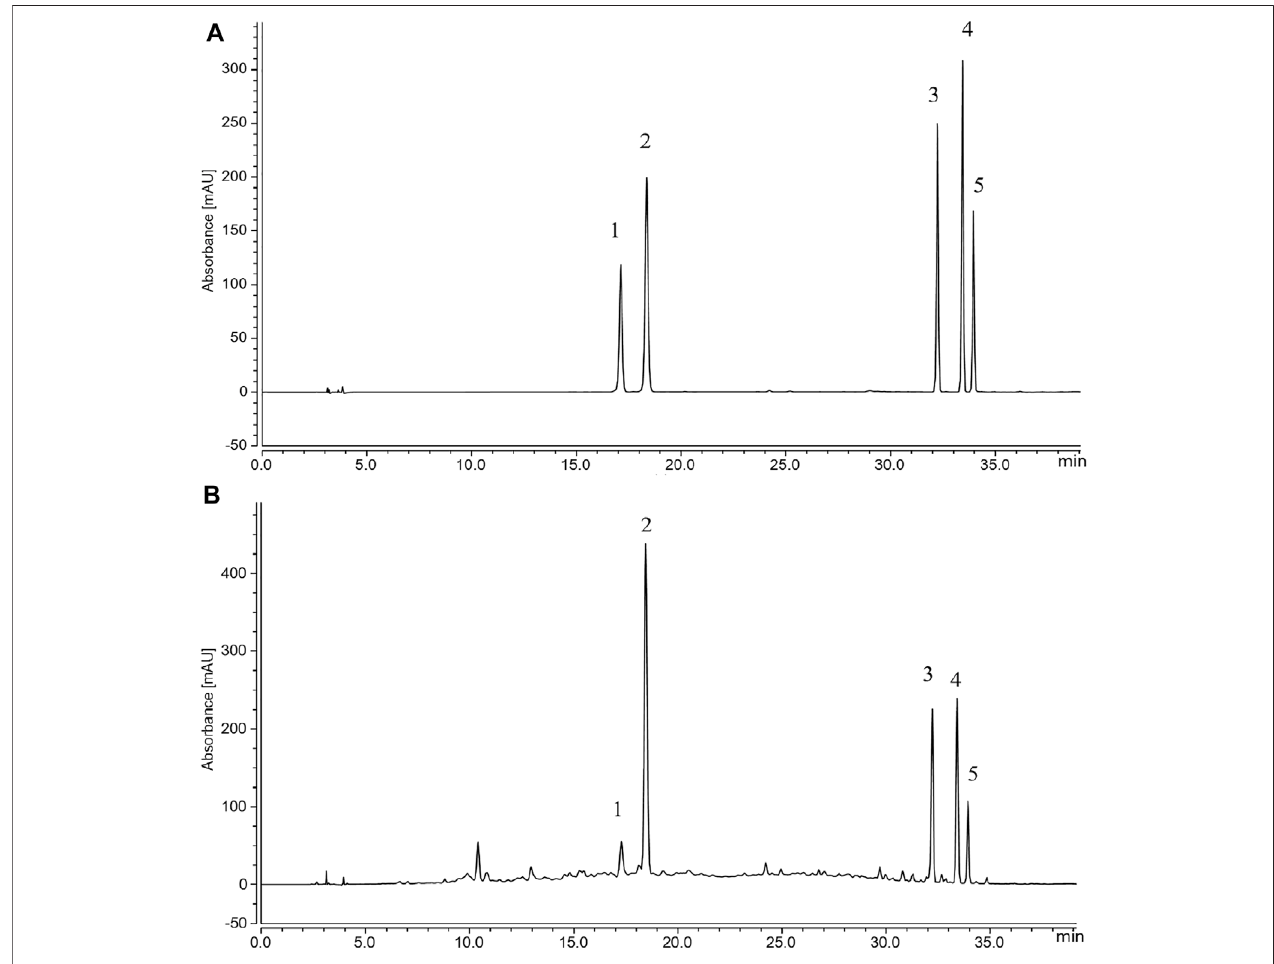
FIGURE 1 | Flavonoids in GPE (A) Standard chromatograms; (B) Flavonoid constituents of GPE: 1. narirutin; 2. hesperidin; 3. nobiletin; 4. tangeretin; 5.5- demethylnobiletin.